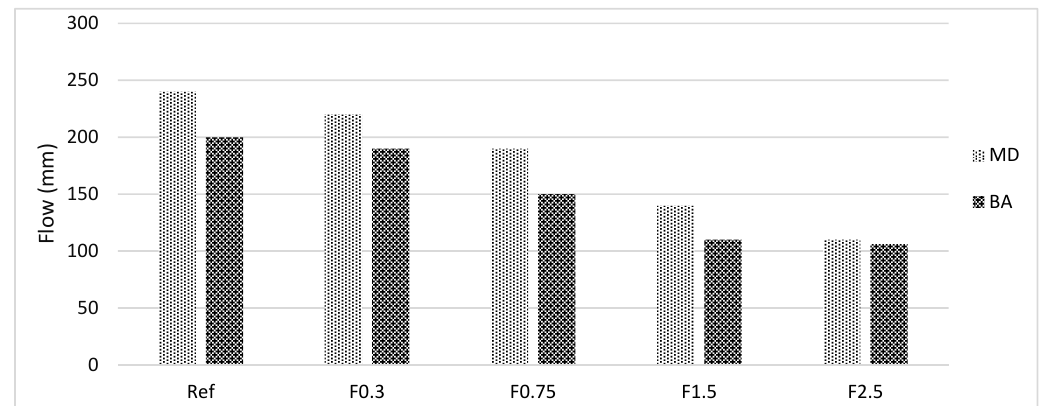
Figure 4. E ff ect of carbon fiber on flow properties of marble dust and bottom ash mixture groups.